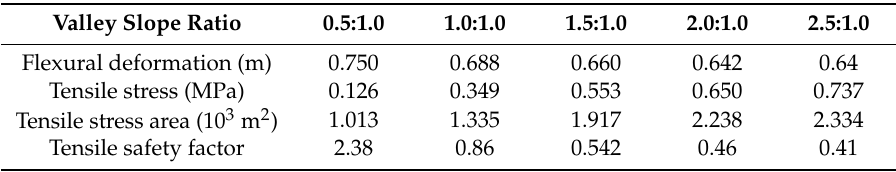
Figure 25. Relationship between tensile stress area maximum of SACC and valley slope ratio. Table 8. Flexural deformation, tensile stress, tensile stress area, and tensile safety factor of SACC with di ff erent valley slope